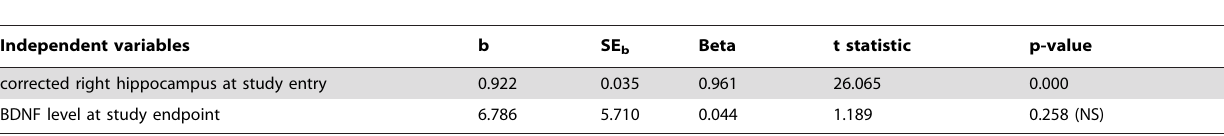
Table 6. Final multiple linear regression model through the origin of corrected right hippocampus at the study endpoint (as dependent variable).